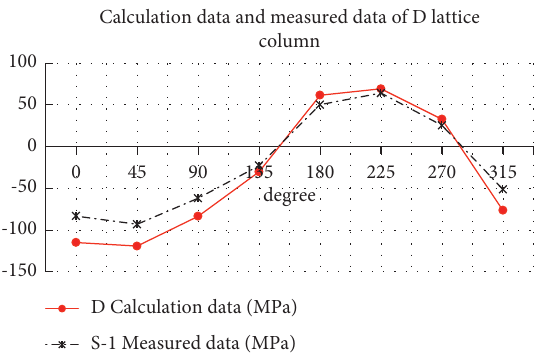
Figure 16: Comparison chart of calculated stress and measured stress of D lattice